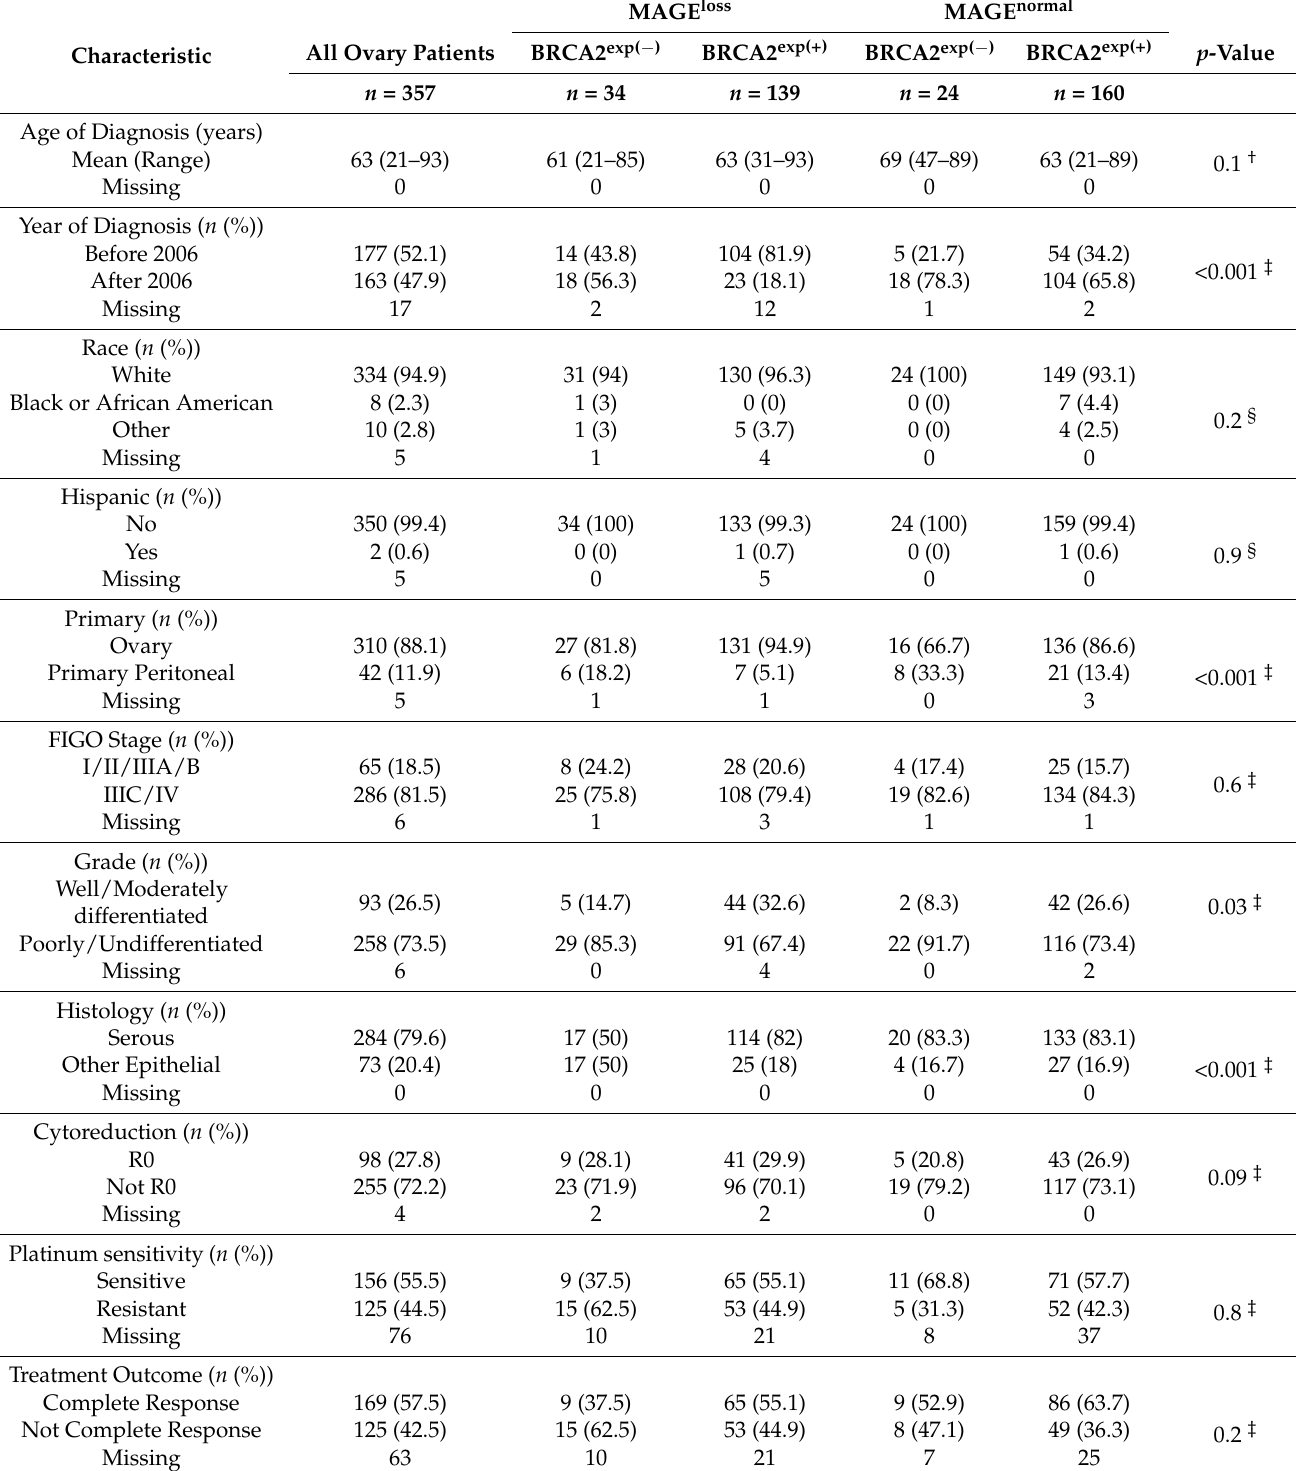
Table 1. Clinical characteristics of the ovary discovery cohort by MAGEC3 and BRCA2 protein expression